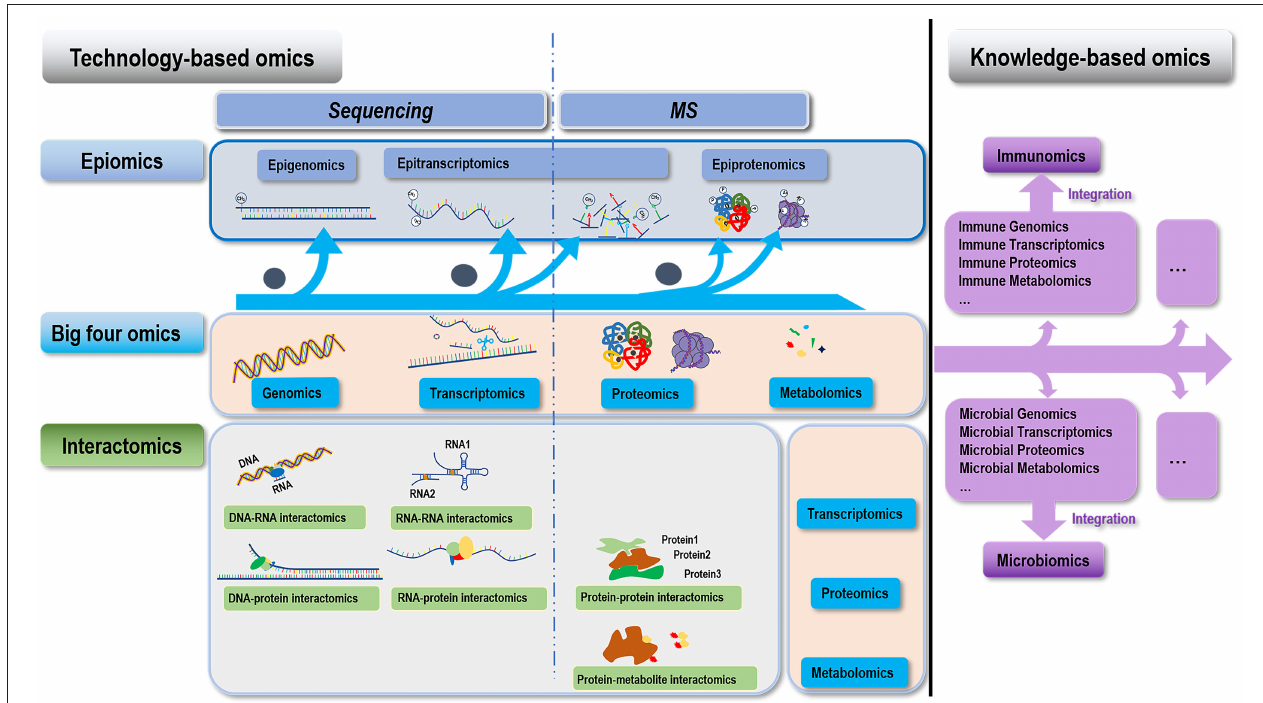
FIGURE 1 | Conceptual illustration on the hierarchy of different omics covered in this paper. We classify omics technologies into two categories, i.e., technology- and knowledge- based. Technology-based omics are based on technologies developed for understanding the “central dogma,” which can be further divided into three groups, i.e., the “four big omics” (genomics, transcriptomics, proteomics, and metabolomics), epiomics (epigenomics, epitranscriptomics, and epiproteomics), and their interactomics (DNA-RNA interactomics, RNA-RNA interactomics, DNA-protein interactomics, RNA-protein interactomics, protein-protein interactomics, and protein-metabolite interactomics). Omics indicated by the horizontal (above) and vertical (right-hand side) pink boxes of each interactomic term constitute to its two interacting omics. Knowledge-based omics are developed to understand a particular knowledge domain in a systematic way through integrating multiple omics information. Examples of this category include immunomics, microbiomics, and